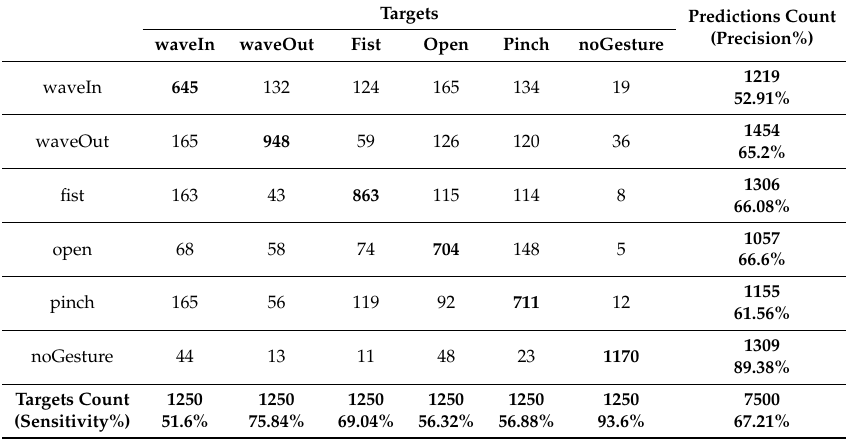
Table A5. Confusion matrix of pinch sync gesture for the user-general HGR model.